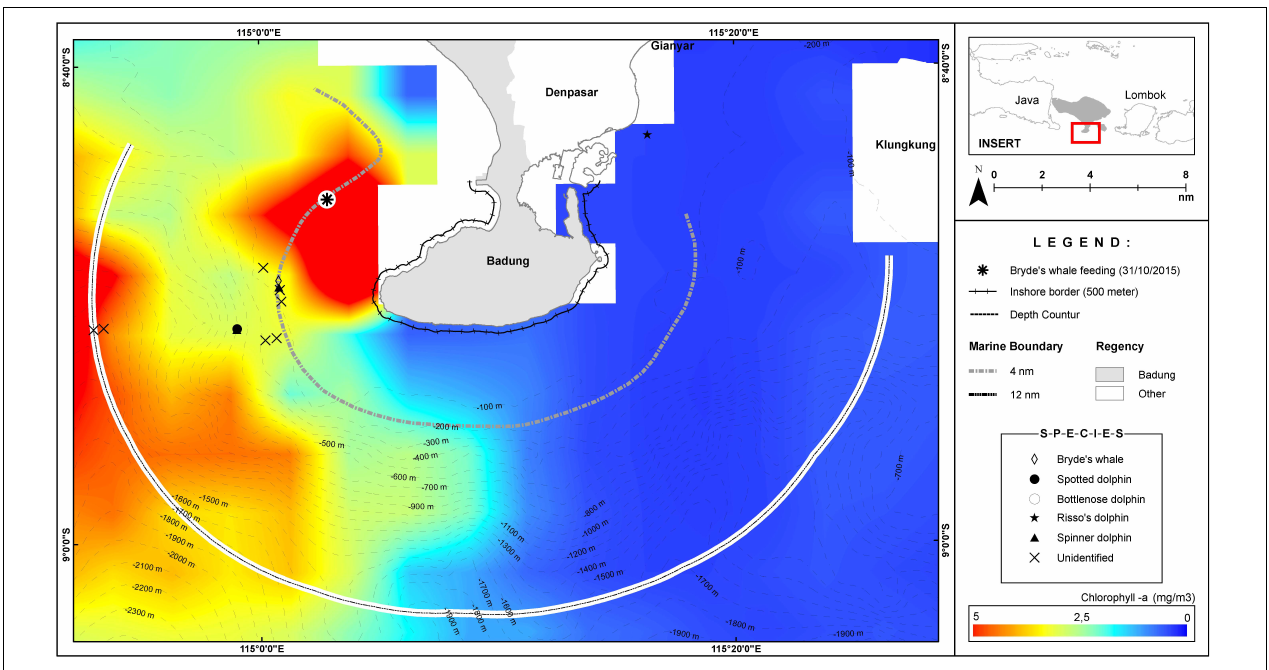
FIGURE 2 | The average chlorophyll-a distribution for October 2015, overlaid with the 31 October 2015 sightings.